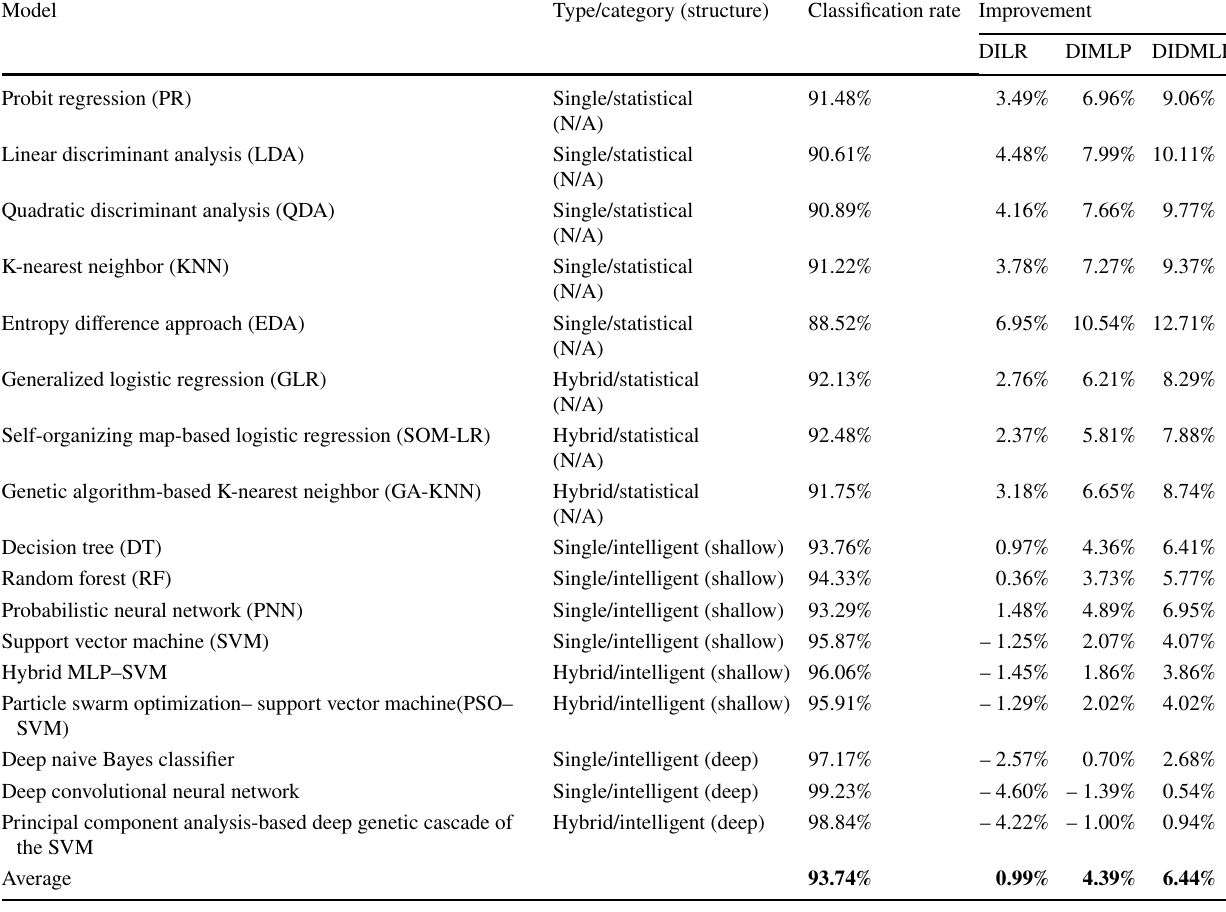
Table 4 Comparison of the presented DILR, DIMLP, and DIDMLP with other classifiers (Auto MPG dataset)